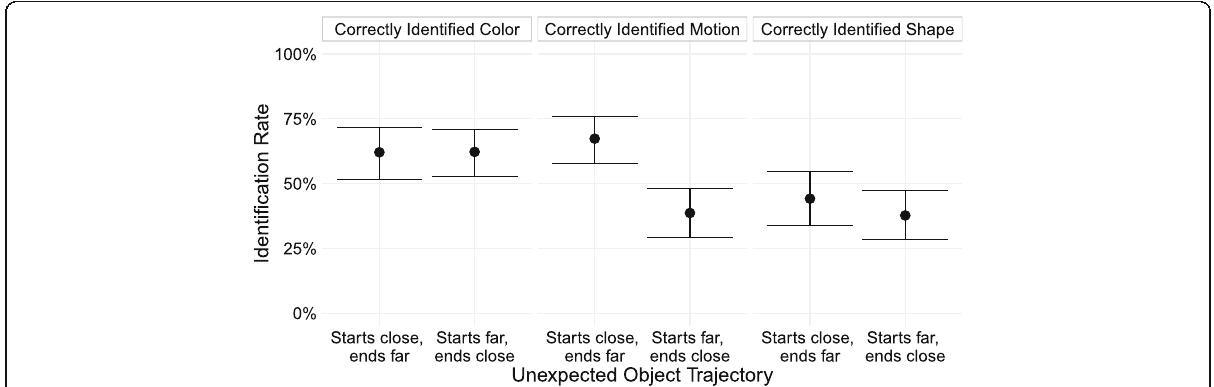
Fig. 6 Rate at which subjects who reported seeing a new object identified the unexpected object ’ s features, broken down by the unexpected object ’ s trajectory. Error bars are 95% bootstrapped confidence intervals. To be counted as correctly identifying a feature of the unexpected object, subjects had to report noticing something new, and: for color, report that the new object was green or yellow; for motion, select the correct trajectory from the cardinal and inter-cardinal directions; and for shape, report that it was a